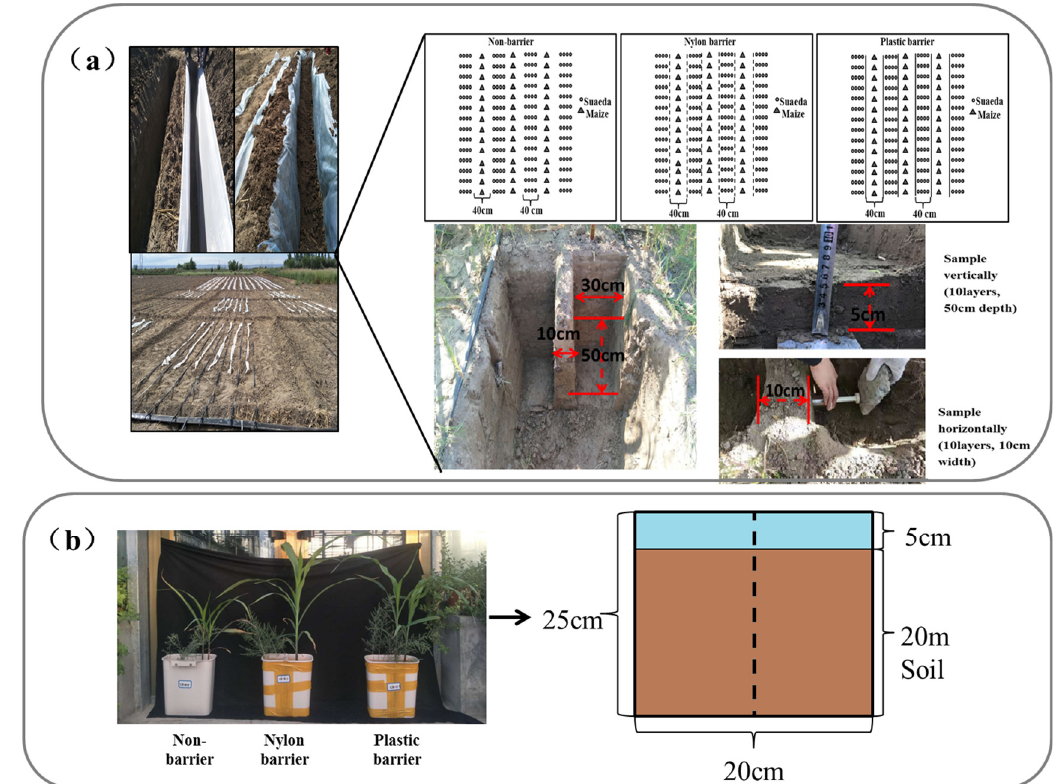
Figure 2. Soil samples from the suaeda/maize intercropping systems: ( a ) In the field experiment, soil samples were collected horizontally at 5 cm depths and vertically at 1 cm depths. ( b ) The pot experiment was conducted in concert with the field experiment.